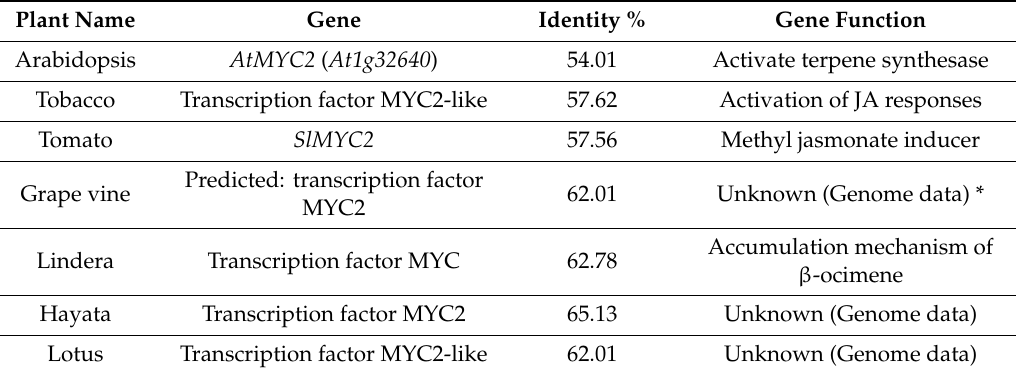
Figure 2. Multiple sequence alignment of the wintersweet CpMYC2 protein sequence with its homologous proteins from other plant species: Cinnamomum micranthum CmMYC2 (RWR86802.1), Nicotiana tabacum NtMYC2 (XP_016500373.1), Solanum lycopersicum SlMYC2 (NP_001311412.1), Vitis vinifera VvMYC2 (XP_002280253.2), Arabidopsis thaliana AtMYC2 (At1g32640), and Zea mays ZmMYC2 (PWZ55921.1). The red box indicates the basic helix-loop-helix DNA-binding domain common in plants. Table 1. Summary of the homology of wintersweet CpMYC2 with genes from other